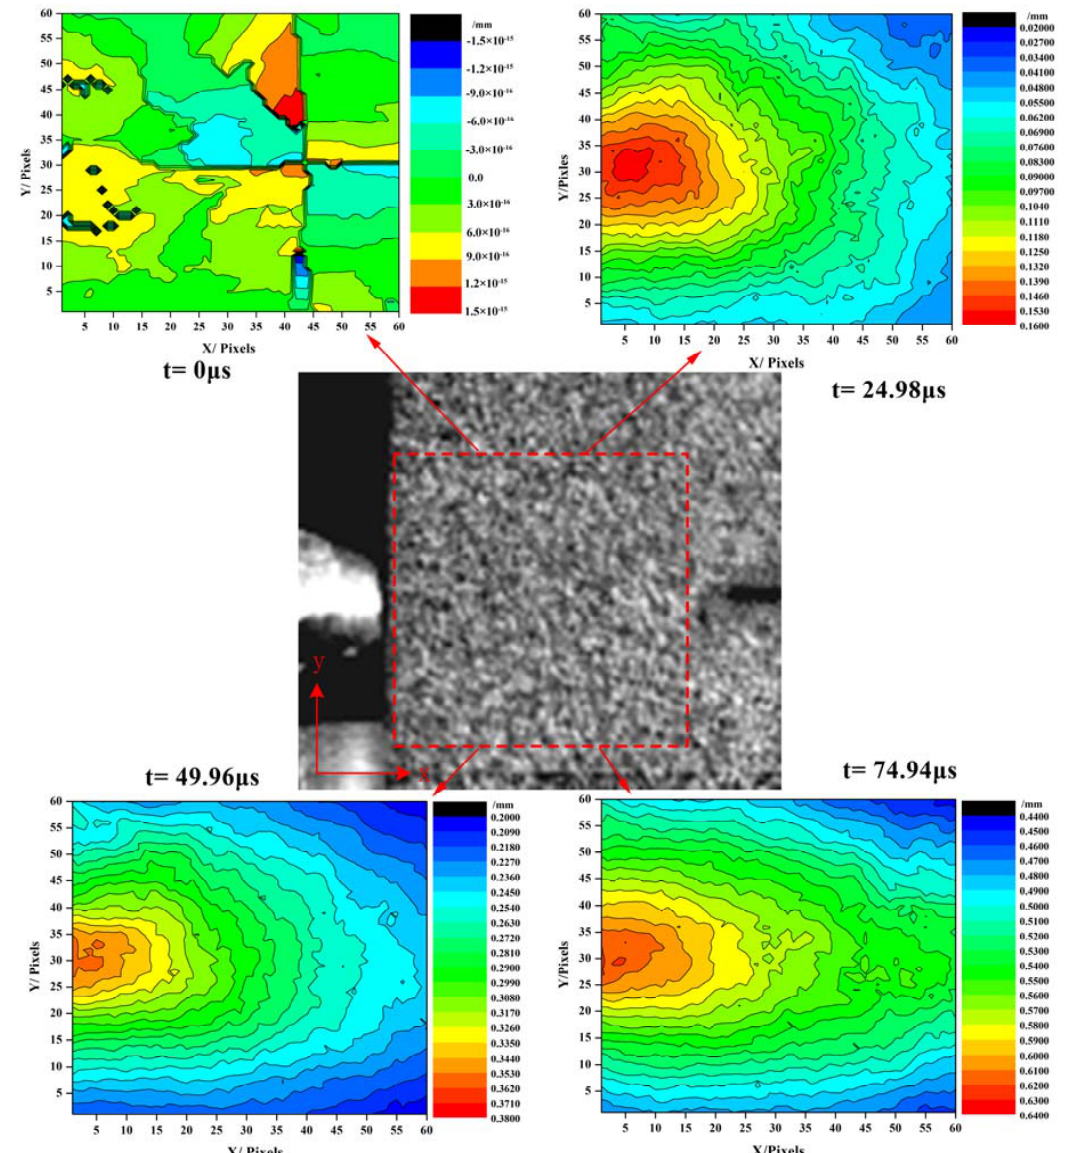
Figure 6. Displacement contour of u x for t = 0 µ s, t = 24.98 µ s, t = 49.96 µ s, and t = 74.94 µ s.